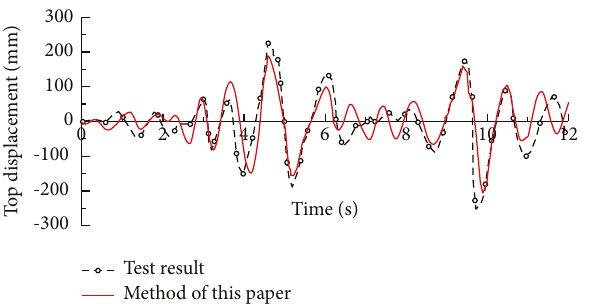
Figure 7: Time history curve of structural vertex displacement.